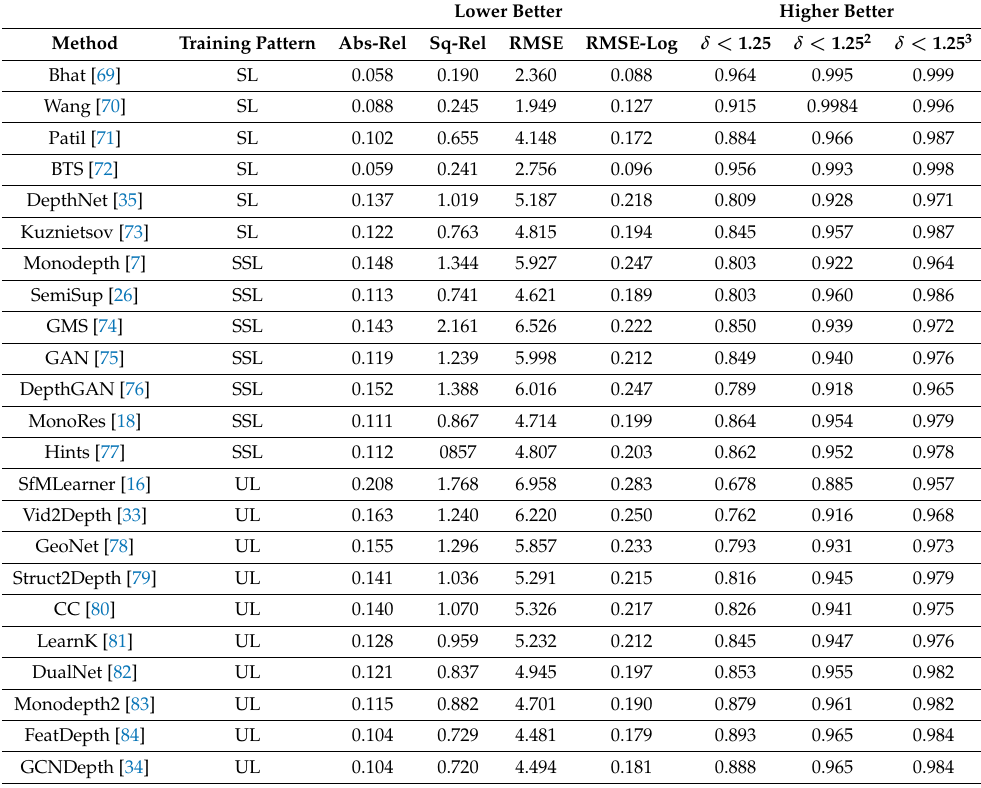
Table 2. Comprehensive information about the quantitative results of the SL, SSL, and UL algorithms investigated on the KITTI